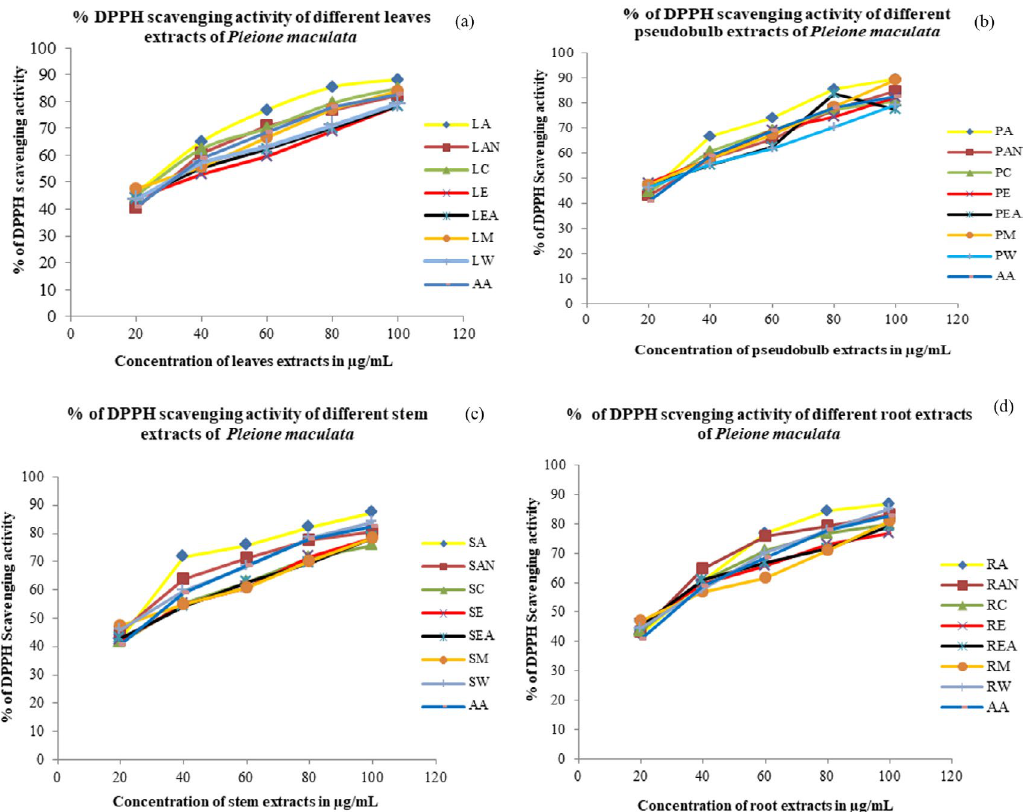
Fig. 2. A plot showing the percentage of DPPH radical scavenging activity of different (a) leave (b) pseudobulb (c) stem and (d) root extracts of P. maculata against Ascorbic acid